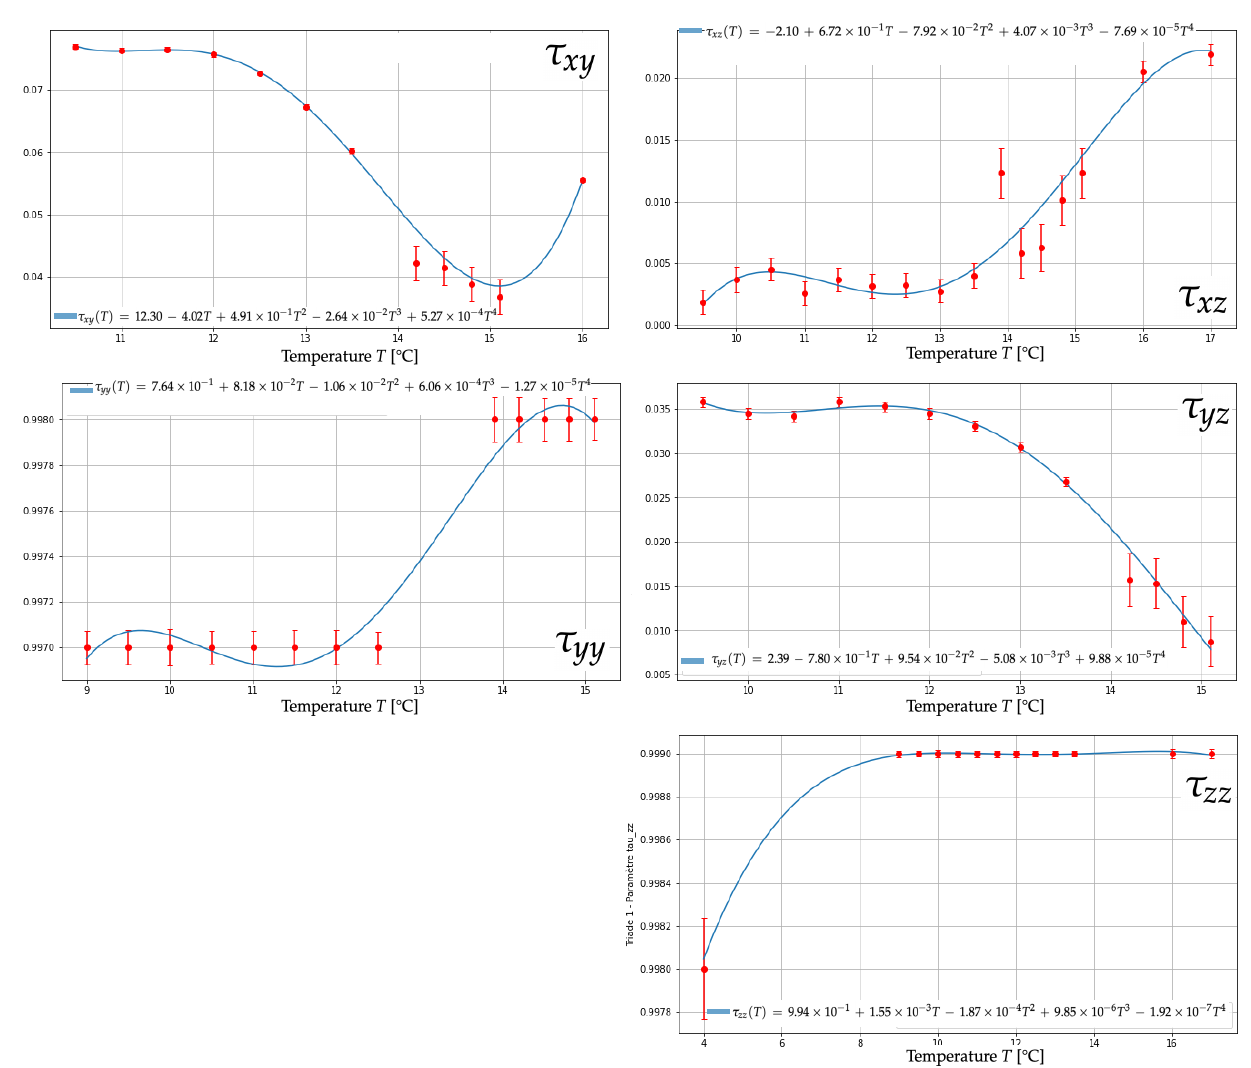
Figure 6. Graphs showing the variation of the parameters τ xy ( top left ), τ yy ( middle left ), τ xz ( top right ), τ yz ( middle right ) and τ zz ( bottom right ) arranged as in the matrix (A15) with temperature for the triad α . The red solid circles correspond to the values of the parameters determined by our adjustment method and are plotted with their 1 sigma error bars. The blue curves represent the result of a polynomial fit with fourth-degree polynomials. Expressions of the polynomials are directly written out on the graphs. For all three polynomial fits, the coefficient of determination was found to be 0.988 ( τ xy ), 0.899 ( τ xz ), 0.975 ( τ yy ), 0.989 ( τ yz ) and 0.997 ( τ zz ). These coefficients did not show a significant increase for polynomial models of degrees greater than 4. The polynomial fits were validated by performing a chi-squared statistical test on the residuals with a 5% risk. This validation required the rejection of some observations that led to the failure of the chi-squared test. The same graphs are available for the triad β